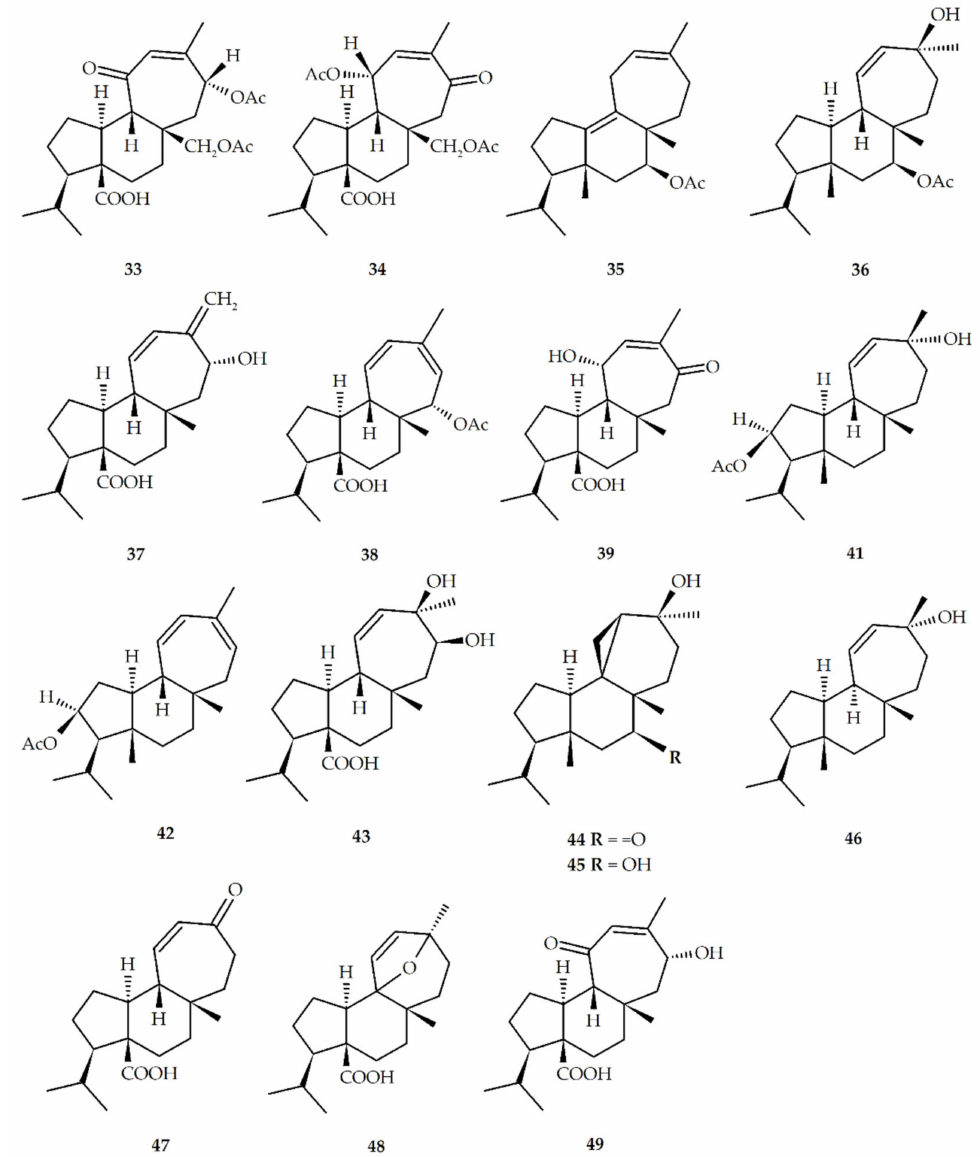
Figure 3. Natural mulinane and azorellane